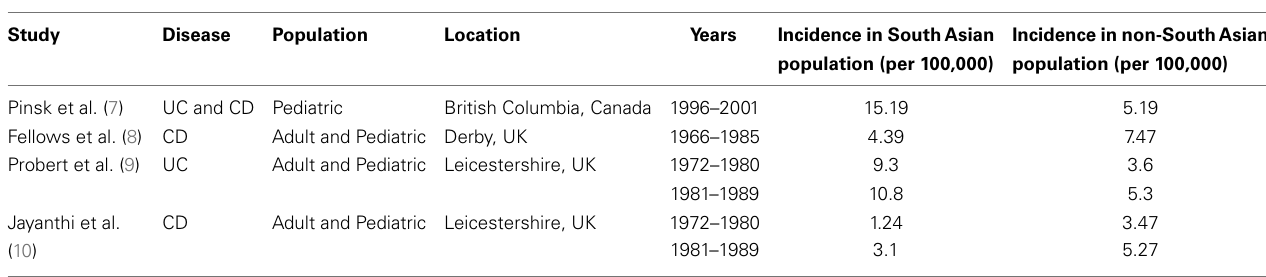
Table 1 | Characteristics of SouthAsian immigrant